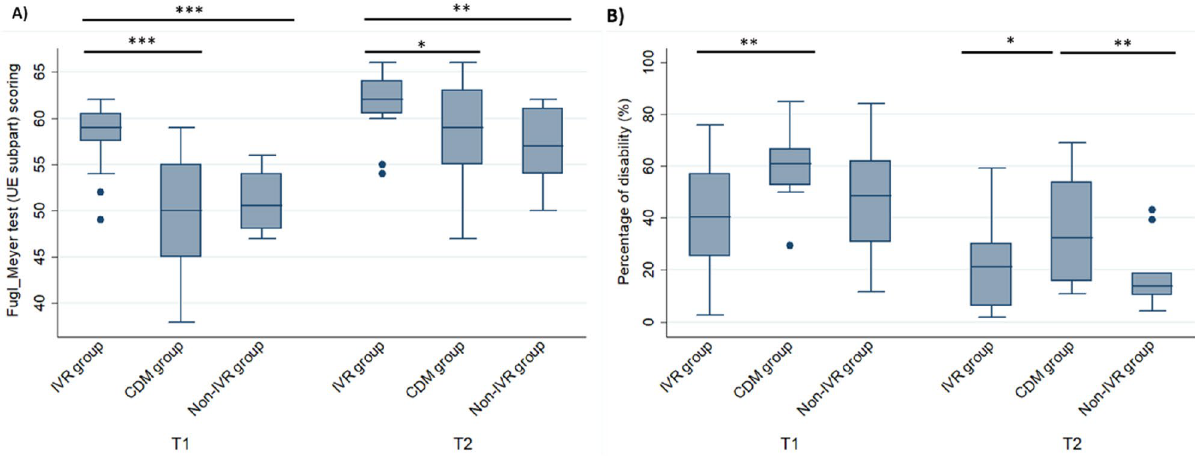
Figure 2. Functional ability recovery and decrease in disability scores. ( A ) Functional ability recovery. The immersive VR training group presented higher functional motor ability recovery after cast removal (T1) and six weeks later (T2) than CDM and non-immersive VR training groups, assessed by Fugl-Meyer test. ( B ) Upper limb disability scores. IVR group presented lower arm disability scores after the cast removal (T1) than CDM and Non-IVR groups, assessed using the DASH questionnaire. At T2 immersive VR and non-immersive VR groups presented lower arm disability scores compared with the CDM training group. In the boxplots, the medians are shown as horizontal lines and the boxes are the interquartile ranges (IQR). The whiskers are between max (min score, lower quartile -1.5 IQR) to min (max score, upper quartile + 1.5 IQR). If there are values outside the whiskers these are conventionally called “outliers” and are shown by ( ∘